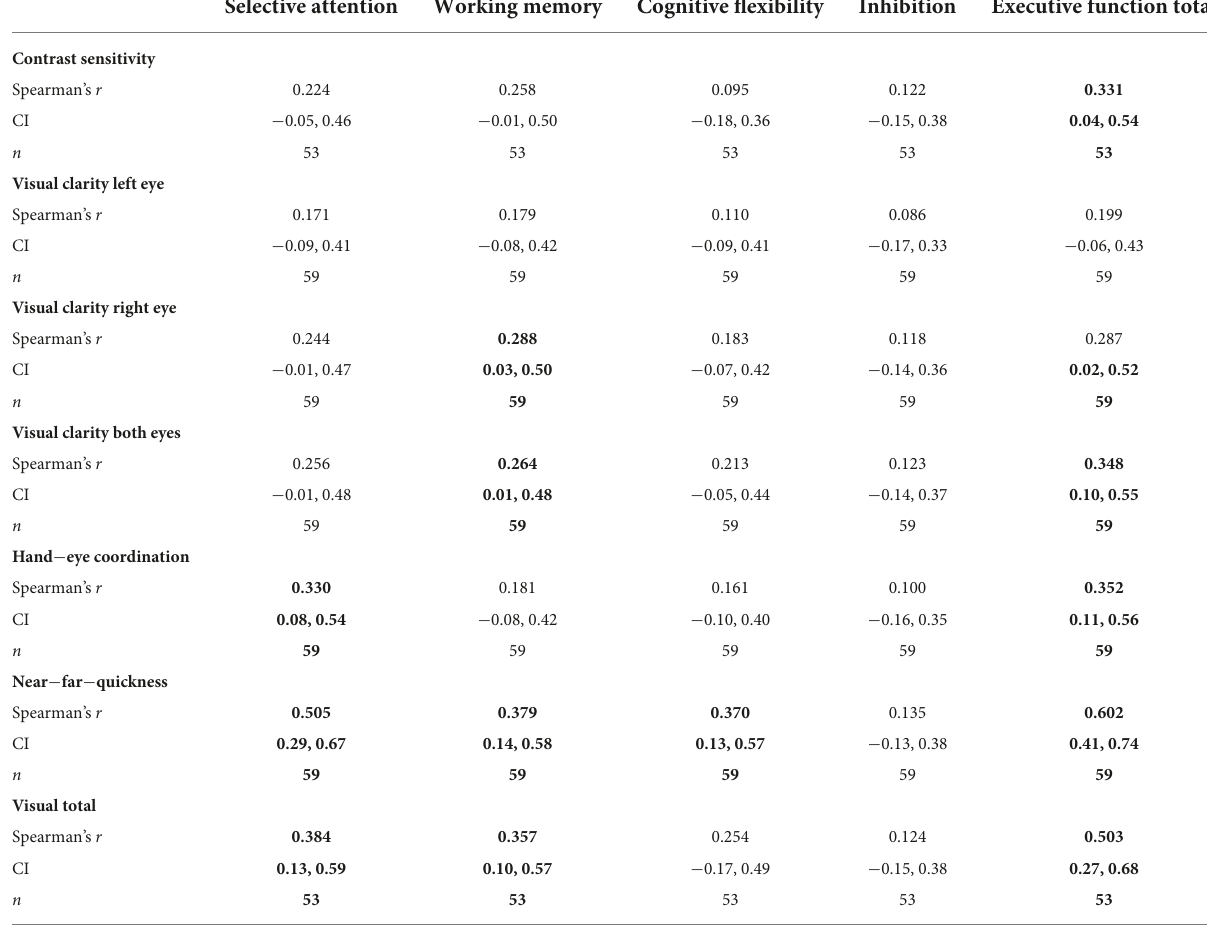
TABLE 1 Bivariate correlations between the executive and visual functions. Selective attention Working memory Cognitive flexibility Inhibition Executive function